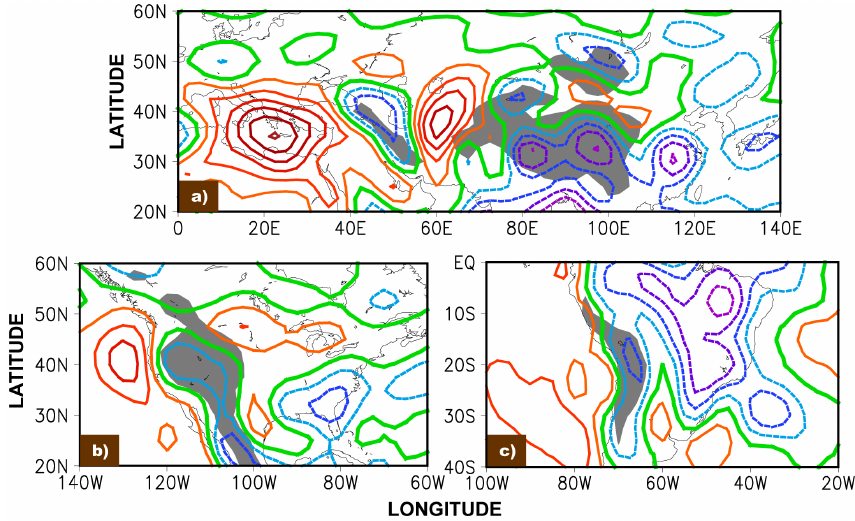
Fig. 8. Distributions of “vertical velocity” ω at 500hPa over (a) the Afro-Eurasia Continent in July, (b) North America in July, and (c) South America in January. Contour interval is 2 × 10 − 2 Pas − 1 . Solid and dashed lines indicate air descent and ascent, respectively; the green line denotes the zero isoline, and gray shading indicates topography above